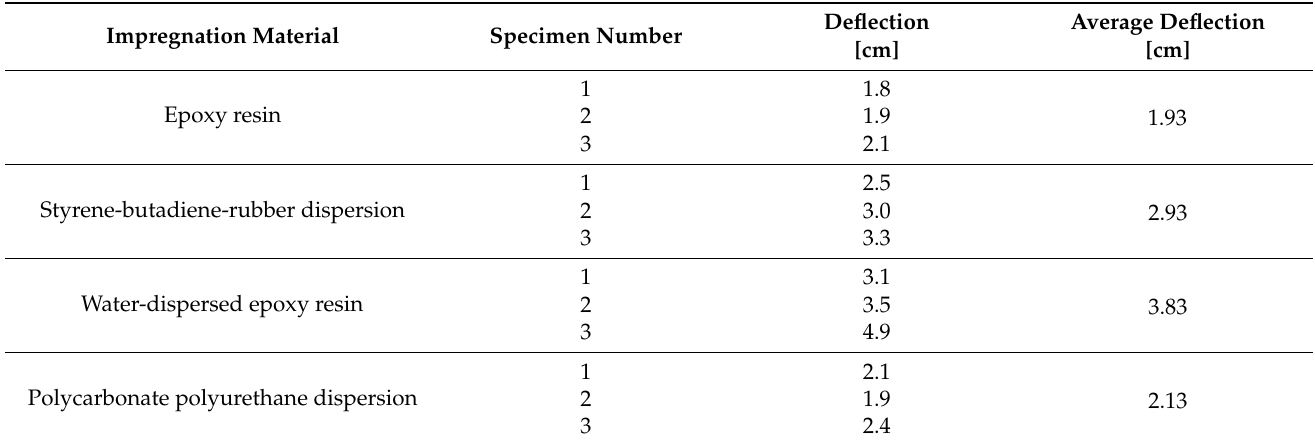
Table 4. Results of the cantilever tests.